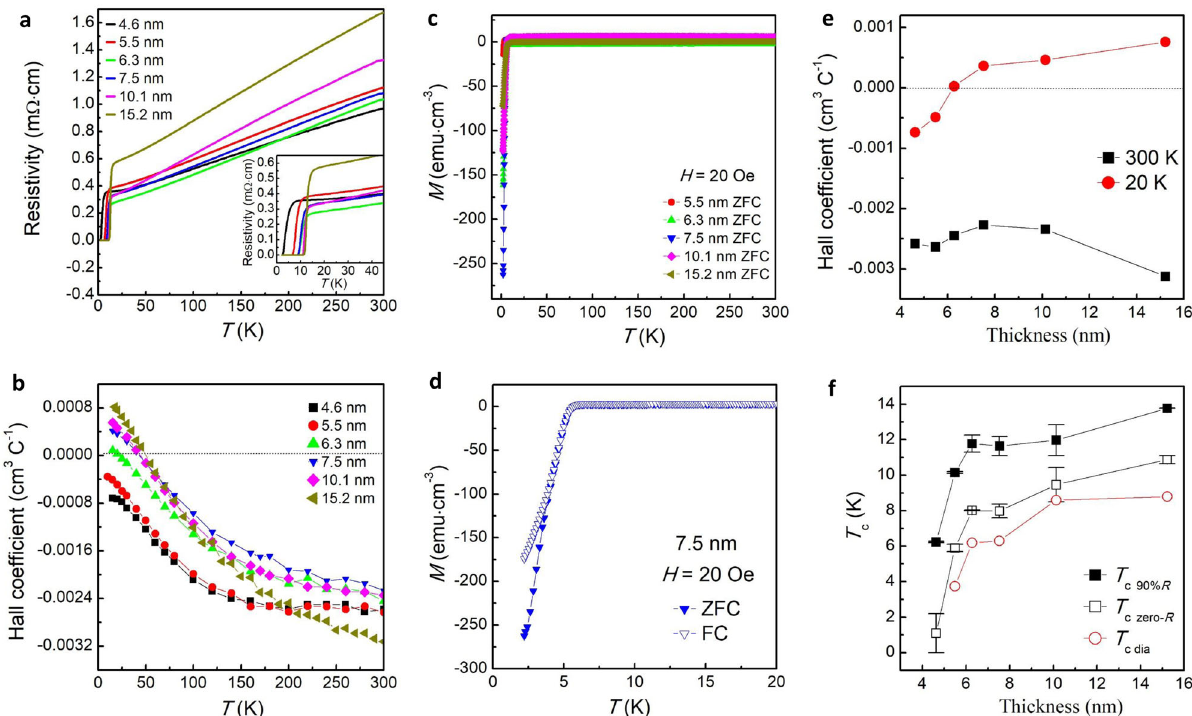
Fig. 2 Thickness dependence of the transition temperature, diamagnetic response, and Hall coef fi cient. a The resistivity versus temperature ( ρ - T ) curves of the Nd 0.8 Sr 0.2 NiO 2 thin fi lms with different thicknesses from 4.6 to 15.2 nm. The inset shows the zoomed-in ρ - T curves at temperatures from 50 to 2 K. b The temperature dependence of the normal-state Hall coef fi cients R H . c The temperature dependence of magnetization ( M - T curve) with zero- fi eld cooling (ZFC) for Nd fi lms with different thicknesses from 5.5 to 15.2 nm. d T he zoomed-in M - T curves at temperatures from 20 to 2.1 0.8 Sr 0.2 NiO 2 thin K with fi eld cooling (FC) and ZFC for the sample with a thickness of 7.5 nm. The measurement and cooling fi elds are 20 Oe. The magnetic fi eld is applied perpendicularly to the a - b plane. e The R H at T = 300 and 20 K as a function of thickness. f The critical temperature, T c , as a function of thickness. The T fi ned as the temperature at which the resistivity drops to 90% of the value at 15 K (the onset of the superconductivity). The T c,90% R is de as the temperature at which the resistivity drops to be zero and T c,dia is de fi ned as the temperature at the onset of the diamagnetic response. The solid and open square for T c,90% R and T c , zero- R are the average value of two sets of samples shown in the main text and Supplementary Information, and the error bars represent the variation. The dash lines in ( b ) and ( e ) show the position where the R H is